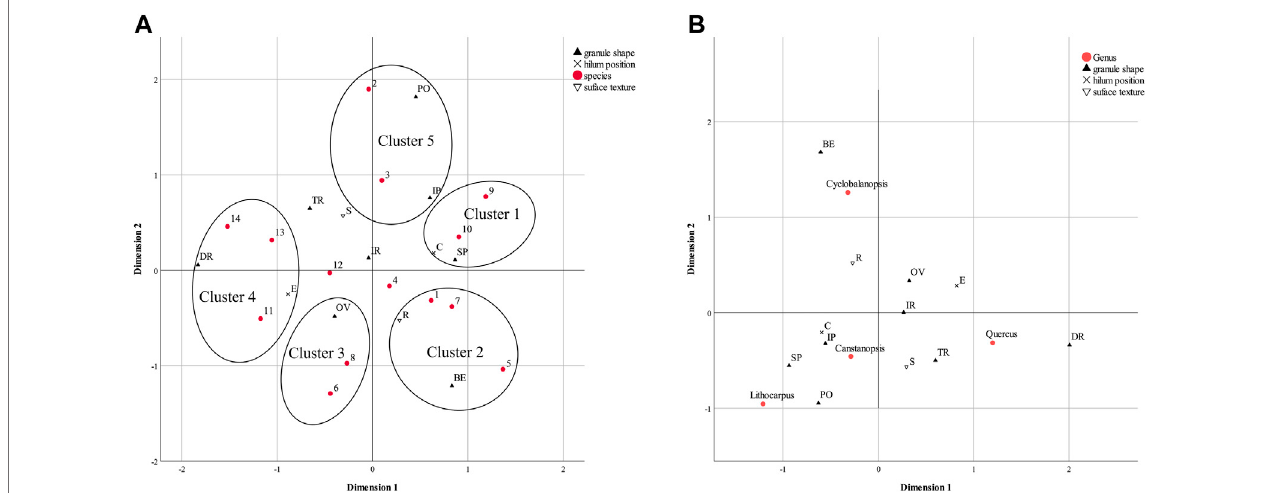
FIGURE6| MCAresultofmorphometricdataofFagaceaestarches: (A) atthespecieslevel; (B) atthegenuslevel.Labels:Species:1, Castanopsisplatyacantha ;2, Castanopsis hystrix ; 3, Castanopsis fargesii ; 4, Castanopsis sclerophylla ; 5, Cyclobalanopsis glauca ; 6, Cyclobalanopsis chapensis ; 7, Cyclobalanopsis gambleana ; 8, Cyclobalanopsis phanera ; 9, Lithocarpus cleistocarpus ; 10, Lithocarpus litseifolius ; 11, Quercus cocciferoides ; 12, Quercus oxyphylla ; 13, Quercus variabilis ; 14, Quercus franchetii . Shapes: BE: bell-shape, DR: drop-shape, FA: faceted sphere, IP: irregular polyhedron, IR: irregular shape, OV: oval shape, PE: pestle shape, PO: polygonal shape, SP: sphere, SC: spherical cap, SS: spindle-shape, TR: triangle. Lamellae visibility: L – A: lamellae absence, L – P: lamellae presence. Surfaces texture: R: rough surface, S: smooth